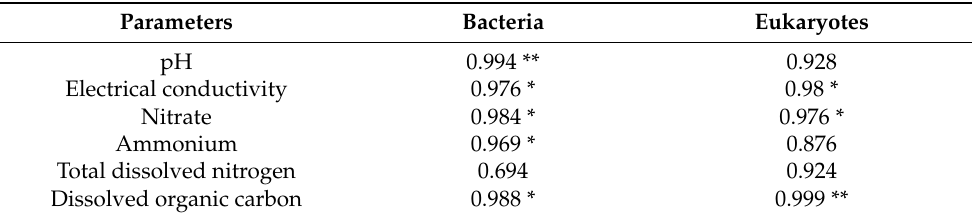
Table 2. Correlation coefficient among bacterial genus, eukaryotic genus, and physicochemical properties of sludge